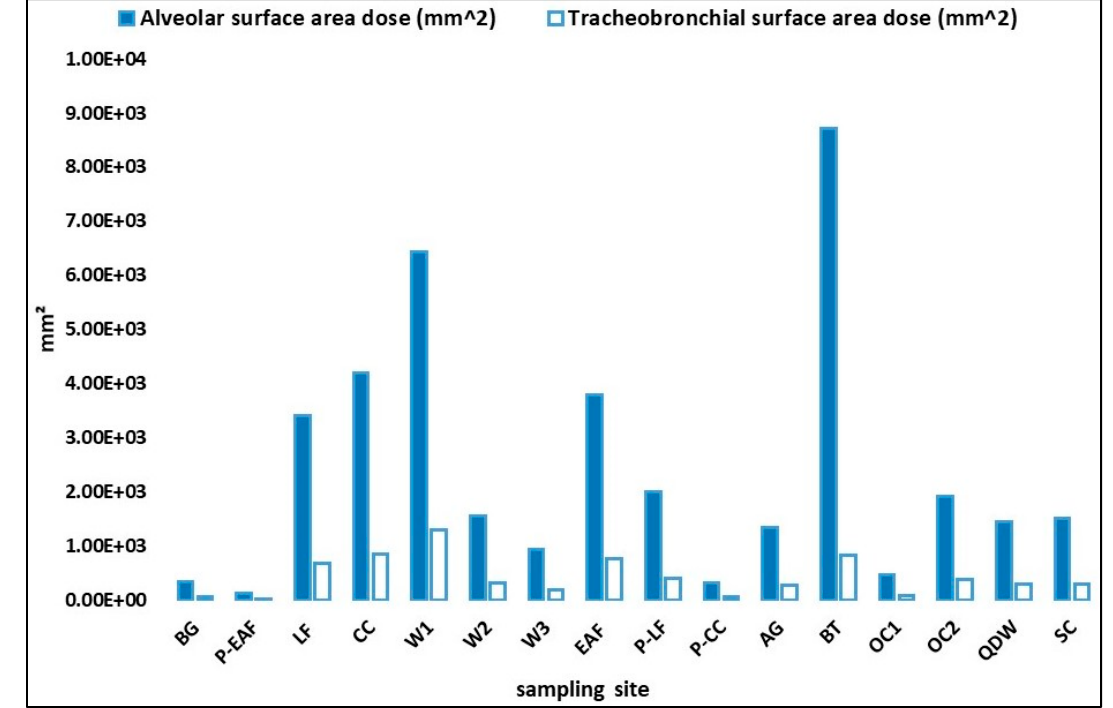
Figure 4. Alveolar deposited surface area dose (mm 2 ) and the tracheobronchial deposited surface area dose (mm 2 ). Both values were weighted for a six-hours exposure. Table 3. Mass concentration (mg/m 3 ) of the inhalable and respirable fractions measured in BG, P-EAF, LF, CC, W1 and W3 sampling